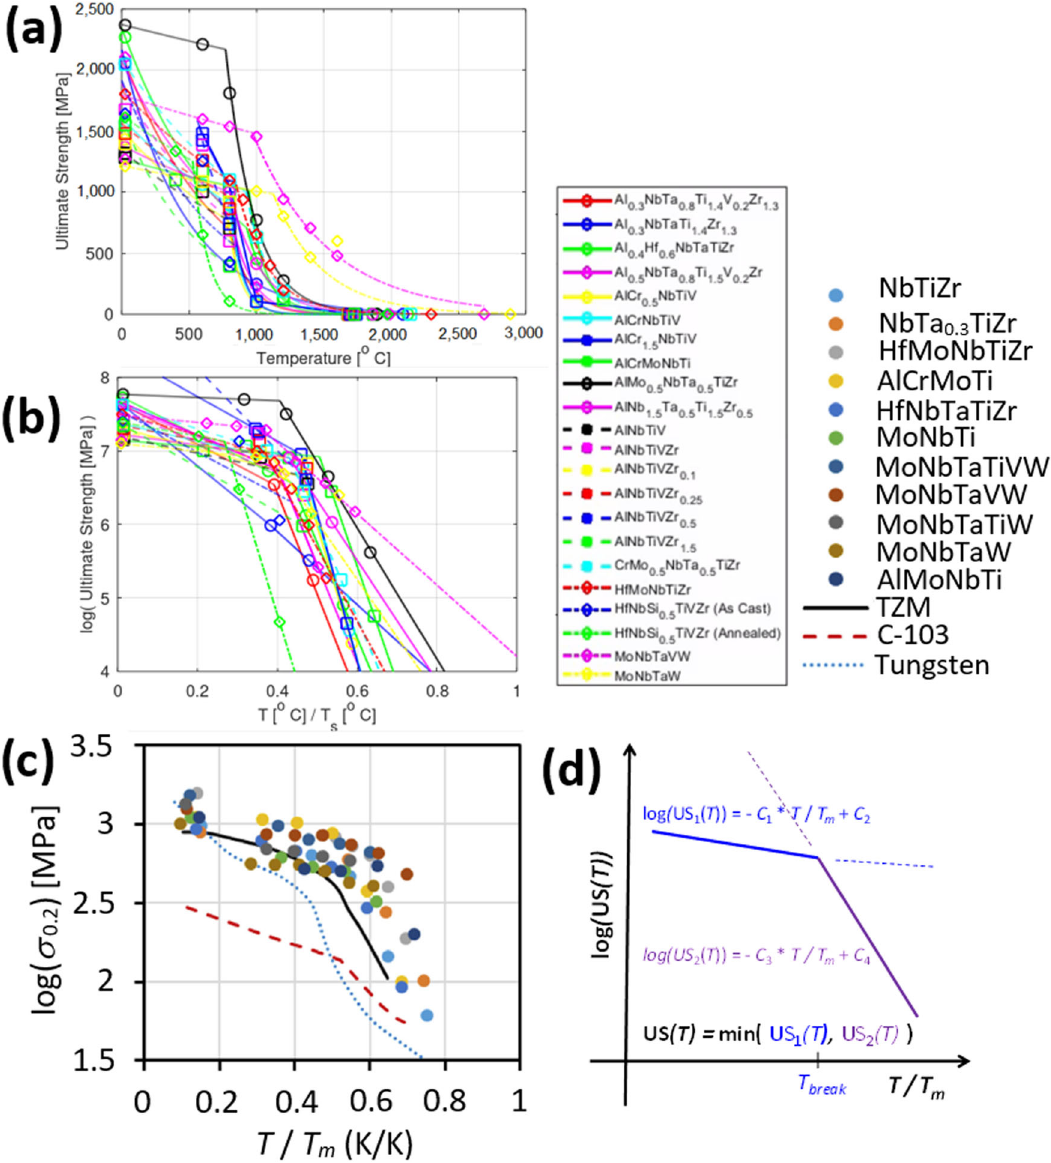
Fig. 3 Identi fi cation of compositions with the ability to retain strengths at high temperatures. Panel ( a ) shows the quality of fi t for the bilinear log model in the linear domain. Panel ( b ) depicts the quality of fi t for the bilinear log model in the logarithmic domain. Panels ( c ) and ( d ) illustrate how experimental measurements of temperature-dependent yield strength naturally conform to two linear regions, when viewed in the logarithmic domain. Panel ( c ) is reproduced from 21 with